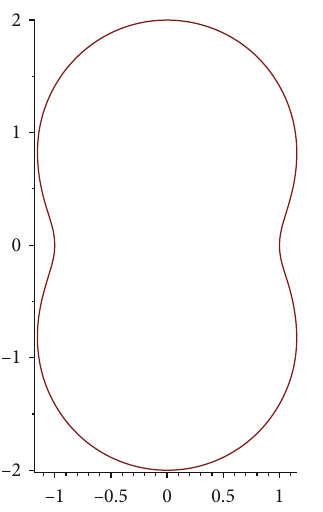
Figure 4: The displayed peanut-like surface is an implicit plot of the vanishing of the fi rst invariant I 1 = 0 (Equation (92)). Inside this surface, the electromagnetic fi eld is of the magnetic type, while outside it, of the electric type, the fi eld is of the null type on this surface. The fi eld is of the nonpure type everywhere, except on the equatorial plane, where it is pure ( I 2 = 0 ). Only in a circle on the peanut ’ s waist, the electromagnetic fi eld reaches the speed of light and there both invariants vanish, in agreement with Equation (16). Hence, there is no light surface, but a light